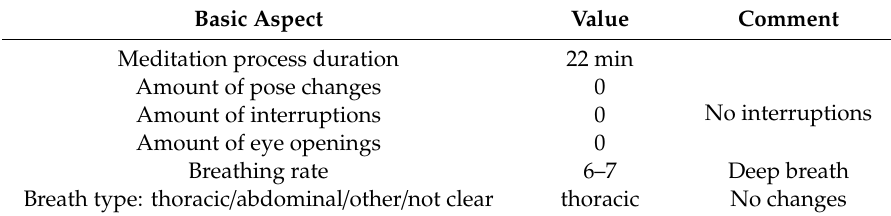
Table 3. Example of meditation analysis process done by a